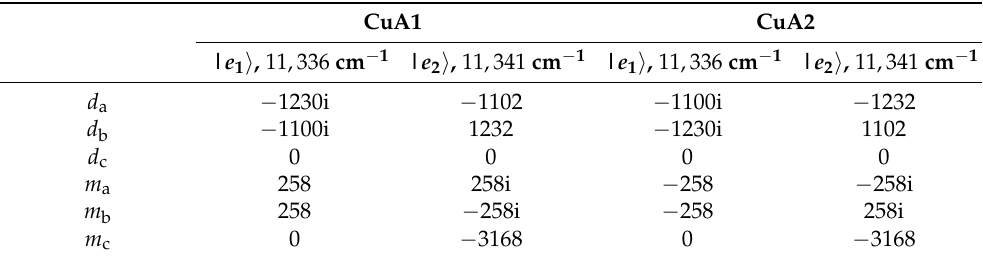
Table 3. Matrix elements (cid:104) g 1 | d α | e 1,2 (cid:105) and (cid:104) g 1 | m α | e 1,2 (cid:105) of the operators of electric and magnetic dipole transitions in arbitrary units for CuA1 and CuA2. CuA1